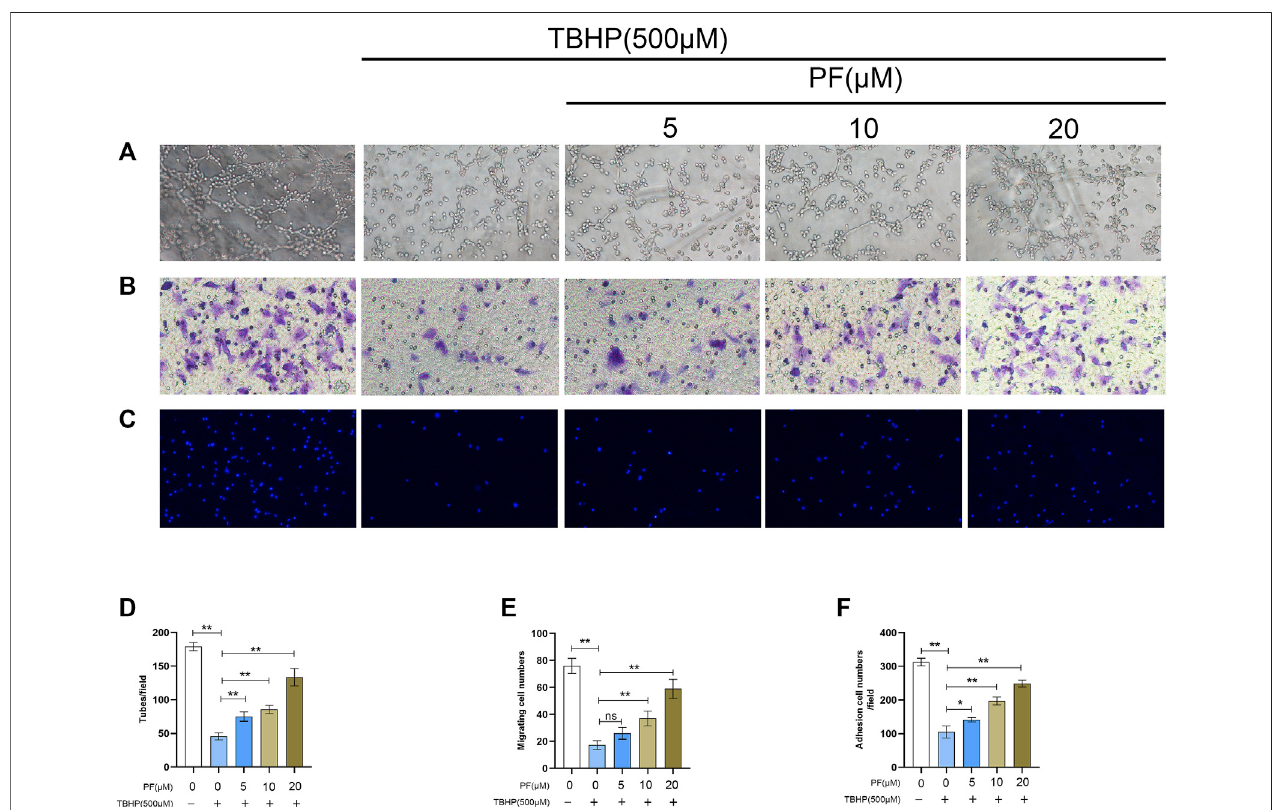
FIGURE 4 | Paeoni fl orin (PF) promoted cell function in TBHP-treated HUVECs. (A,D) Evaluation of PF-mediated HUVEC neovascularization using tube formation assay(scalebar,100 μ m). (B,E) AssessmentofPF-mediatedHUVECmigrationusingthetranswellsystem(scalebar,100 μ m). (C,F) EvaluationofPF-mediatedHUVEC adhesion using cell-matrix adhesion assay (scale bar, 100 μ m). Data: mean ± SD, * p < 0.05 and ** p < 0.01. n (cid:2) 3.